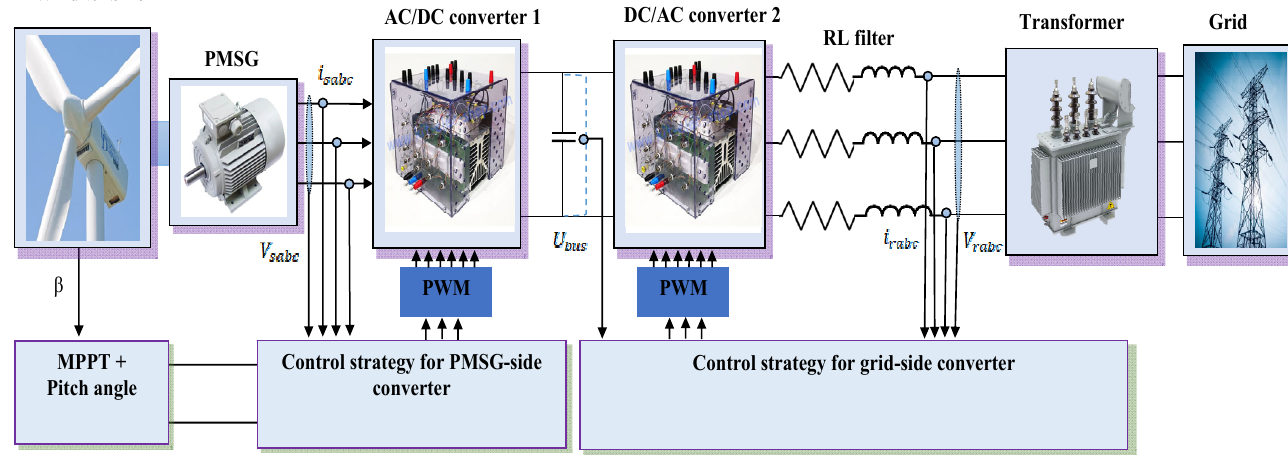
Figure 1. WECS architecture.